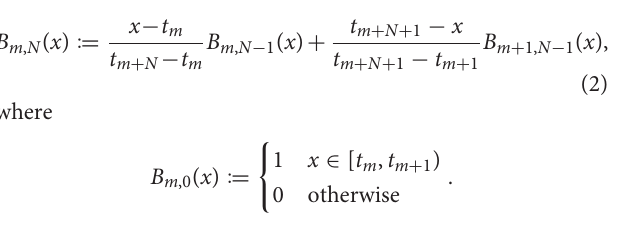
2,3,4,5. The knots T = M 1 for i 1, ... , N . Shown also in black is the sum of all the = = +